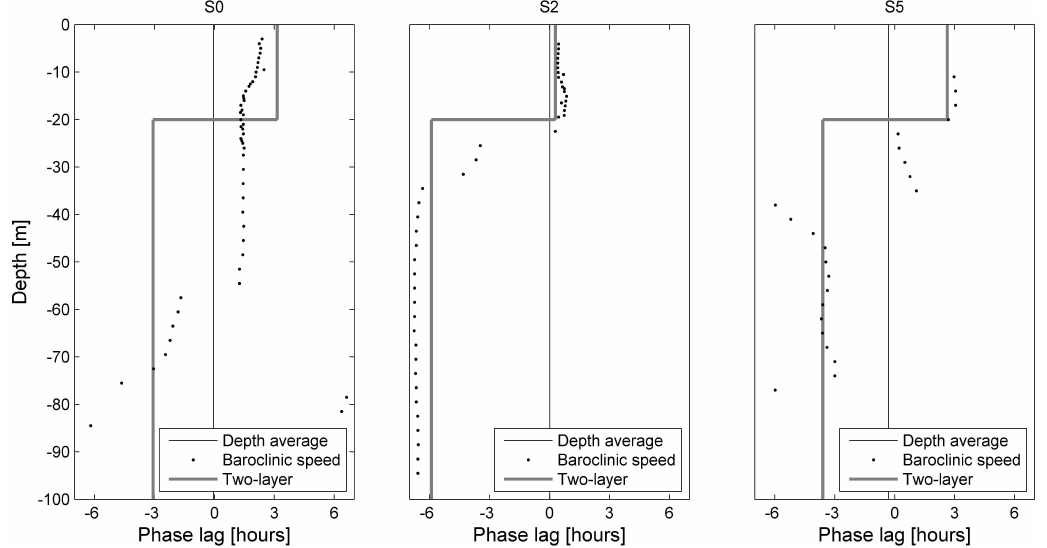
Fig. 7. Phase lag of the current measurements at stations S0 (left), S2 (middle) and S5 (right) relative to the depth-averaged current over the Drøbak Sill (station S1). The vertical solid line is the phase (=0) of the depth-averaged current. The black dots are the phase lags of the measured baroclinic current (Eq. 4) as a function of depth, and the grey lines are the theoretical phase lags from two-layer theory (Eqs. 6–7 and Table